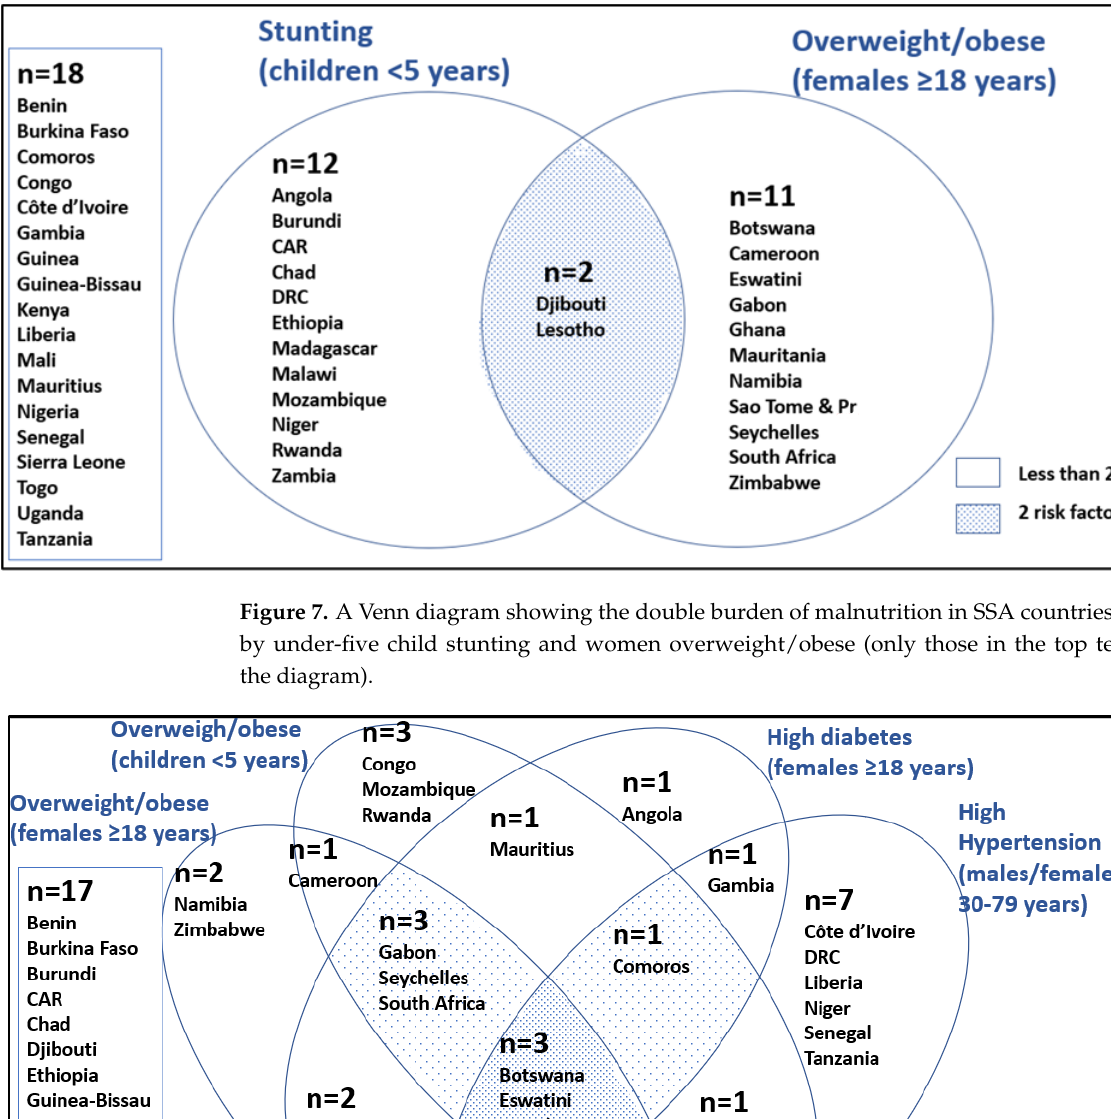
Figure 6. A Venn diagram showing SSA countries lying in the top tertiles for under five child stunt- ing and child overweight (only those in the top tertile are in the diagram). Sao Tome & Pr: Sao Tome and Principe.